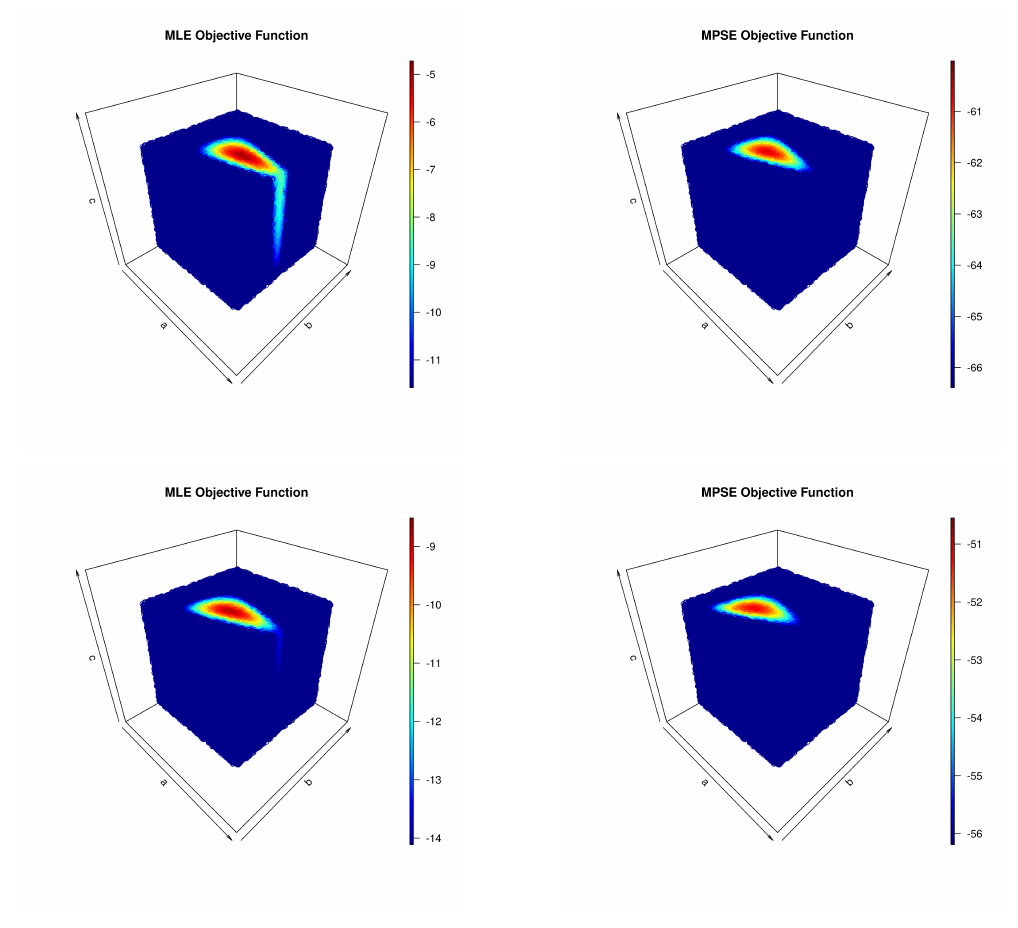
Figure 2. Four-dimensional profiling of the objective functions for complete sample (upper panel) and Type-II censored sample (lower panel). Table 2. Starting (initial) values from the objective functions, based on Table